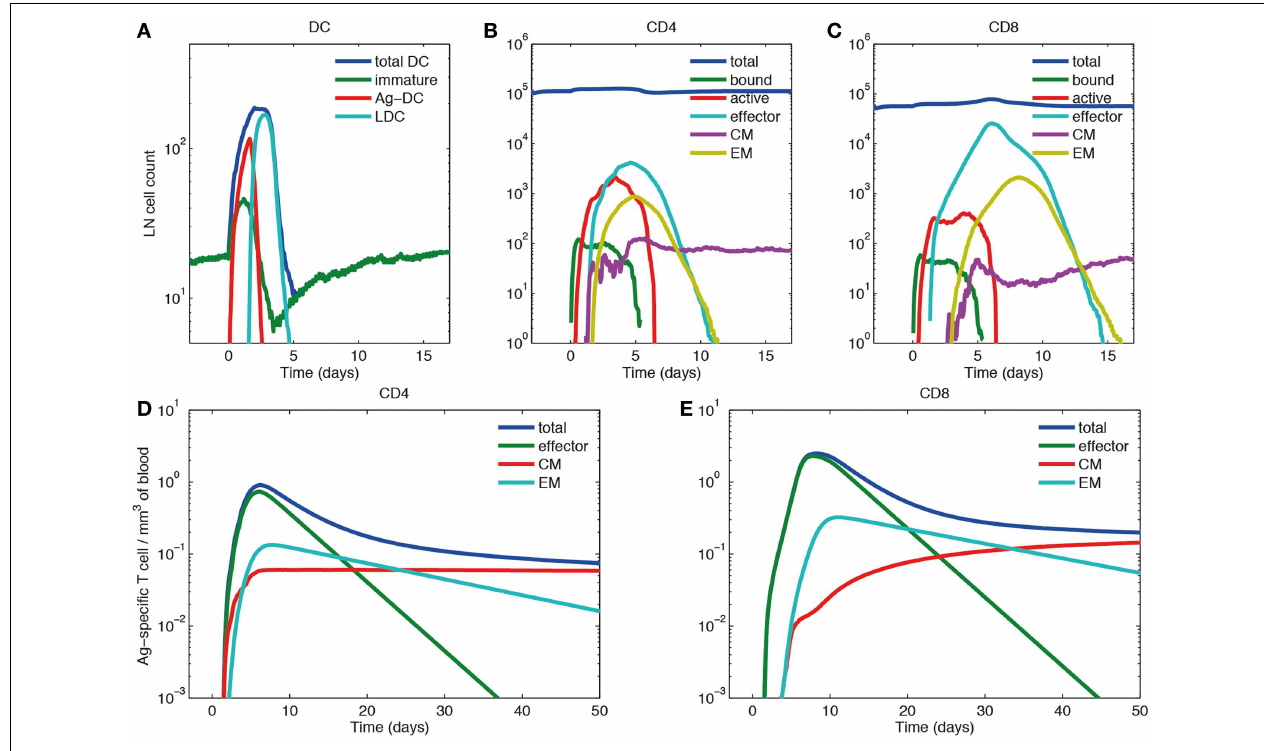
compartment. (D,E) Concentration of CD4 + and CD8 + T cells of different subsets in the blood compartment. (A) Model input of DCs representing a hypothetical acute infection, such as LCMV and (B–E)